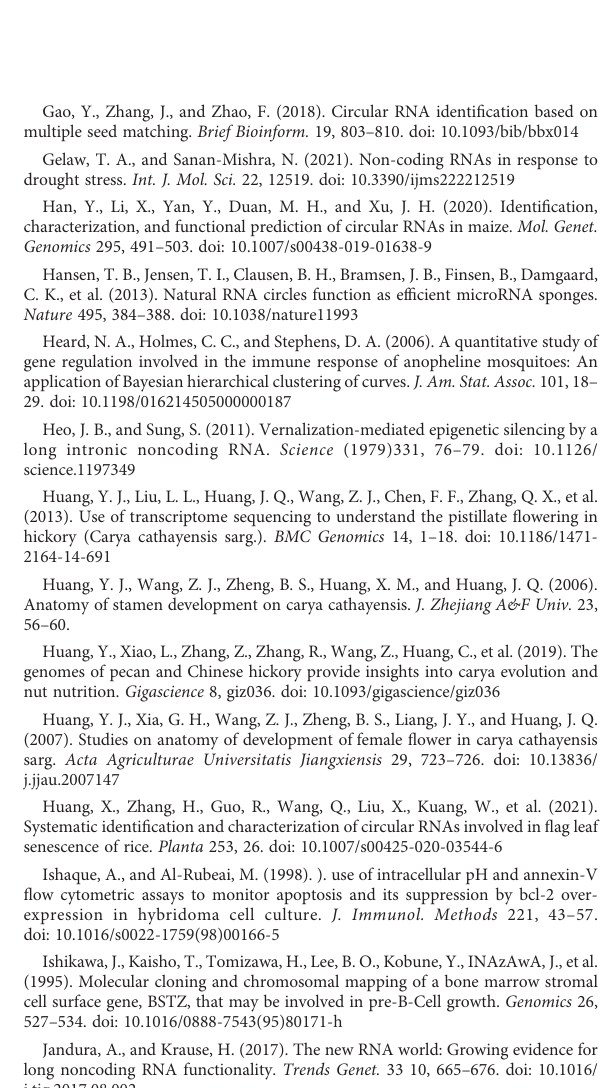
SUPPLEMENTARY TABLE 12 The prediction of circRNA-miRNA-mRNA in M1 compared with M2. SUPPLEMENTARY TABLE 13 Primers for qRT-PCR. SUPPLEMENTARY TABLE 14 The original data and calculation of qRT-PCR. SUPPLEMENTARY FIGURE 1 Characterizations of circRNA in female and male fl ower buds. (A) The distribution of circRNAs. The circRNAs derived from exons were indicated inred,andthosefromintergenicandintronswereshowningreenandblue, respectively. (B) The circRNA length distribution of six libraries. The female (F) and male (M) bud samples were collected at undifferentiated (F1, M1), differentiation (F2, M2), and differentiation completed (F3, M3)